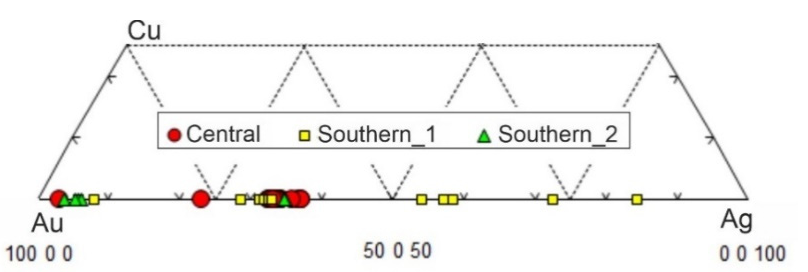
Figure 6. Variations in the composition of Au-Ag solid solutions from different ore zones of the Baranyevskoe deposit (data from Table 2).